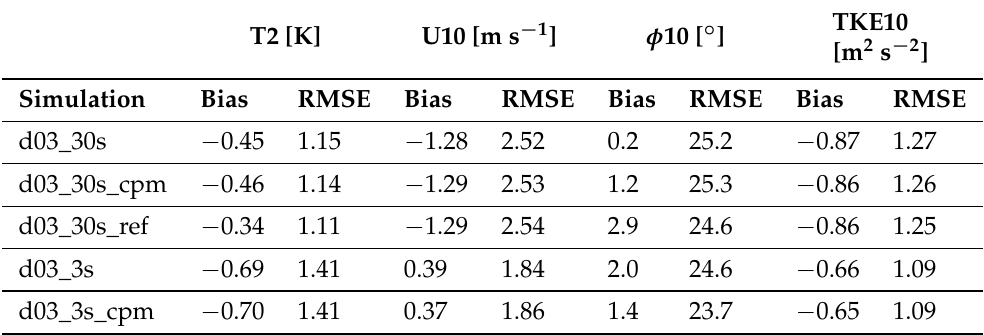
Table 2. Biases and root-mean-square errors (RMSE) averaged over the time period between 1100 UTC on 20 May 2017 and 0000 UTC on 21 May 2017 comparing LES model fields interpolated to the locations of towers, excluding those within the unresolved valley. Biases are averages of the difference taken as model data minus observed tower data. The LES data at 2.5 min output interval is first downsampled as described in the body text.